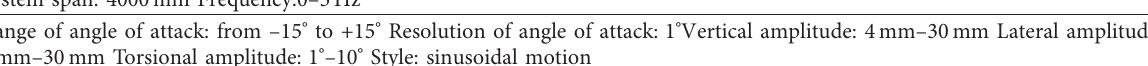
Table 1: Performance parameters of the forced vibration system.